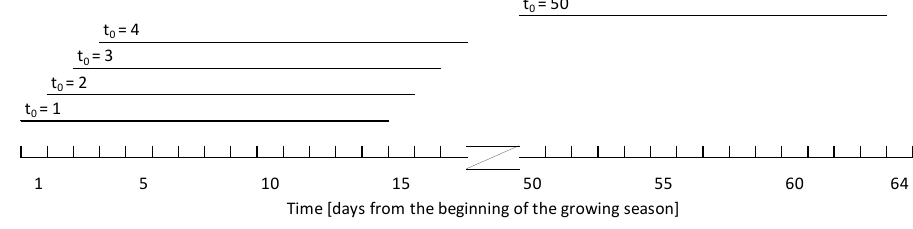
Figure 2. Recurrence of analysis in sliding time windows.